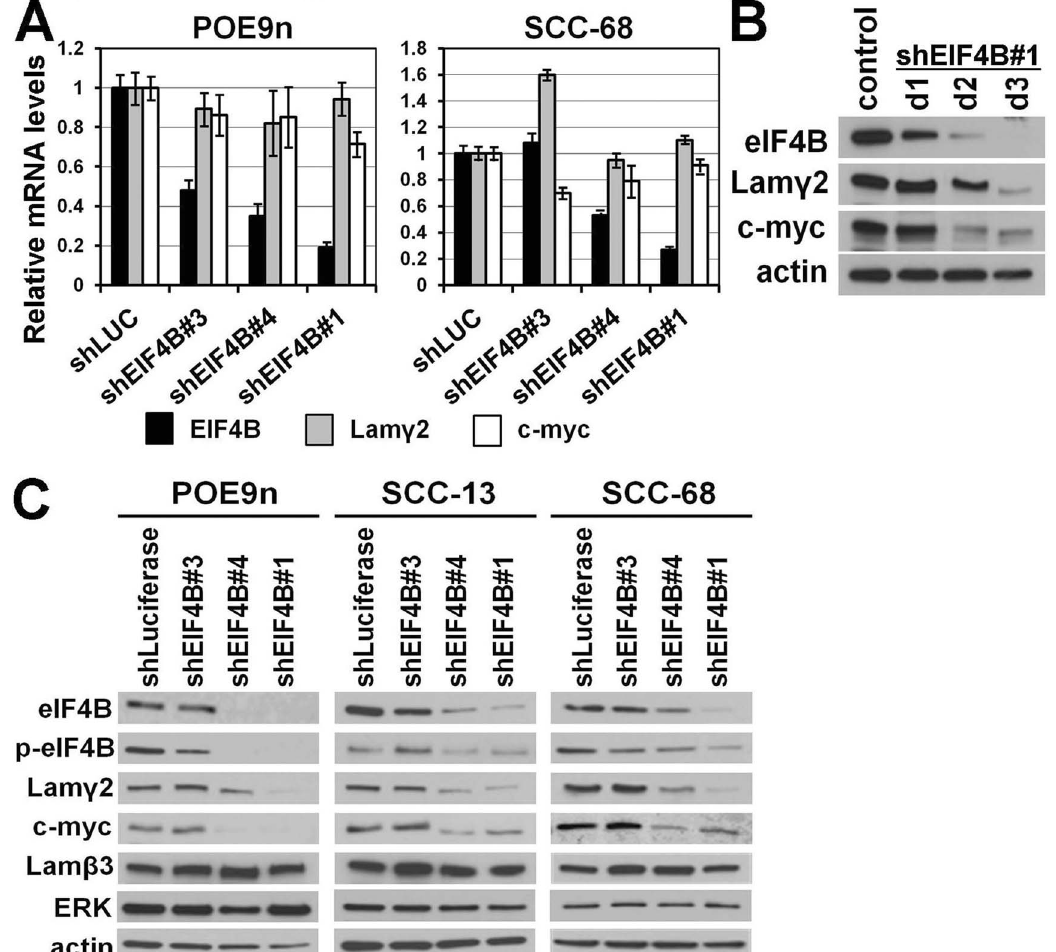
Figure 4. The eIF4B requirement for Lam c 2 and MYC protein expression demonstrated by shRNA knockdown. A ) Effect of eIF4B knockdown on eIF4B, Lam c 2, and MYC mRNA levels. RNA from POE9n and SCC-68 cells transduced to express shRNAs targeting eIF4B or Luciferase was analyzed by qPCR for eIF4B, Lam c 2, and MYC transcripts. Results of each cell line was internally normalized to GAPDH mRNA levels and expressed relative to that of cells transduced to express shLuciferase, set at an arbitrary value of 1. B ) Western blot analysis of the time-course of eIF4B protein reduction in SCC cells transduced to express shRNA.eIF4B # 1 and examined 1, 2, and 3 d after transduction. C ) Western blot analysis of the premalignant cell line (POE9n) and two SCC lines (SCC-13, SCC-68) transduced with three shRNA vectors targeting EIF4B and a control shRNA vector targeting luciferase.